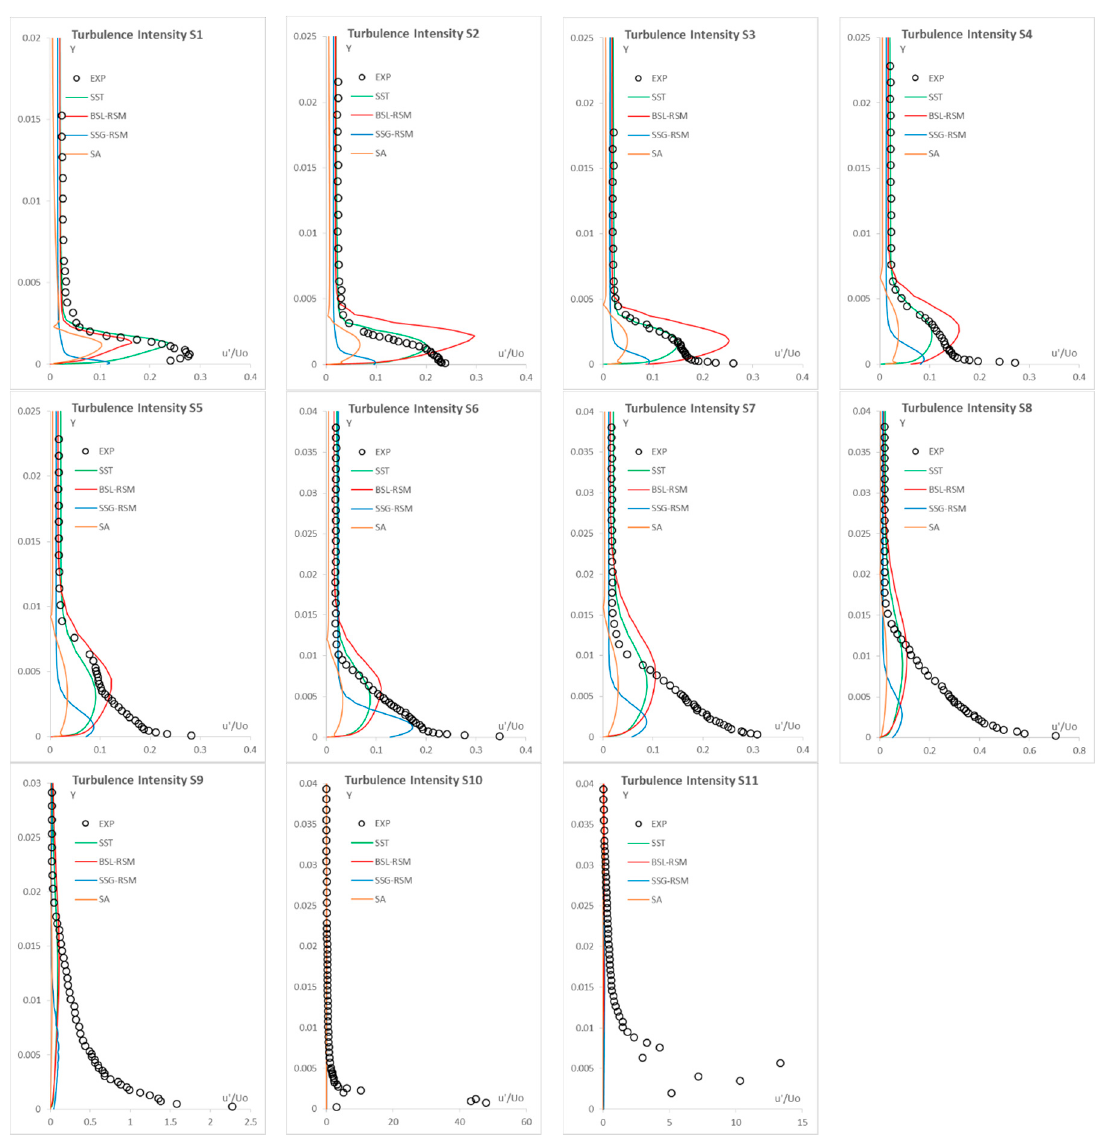
Figure 8. Turbulence Intensity distributions on the DCA suction side.